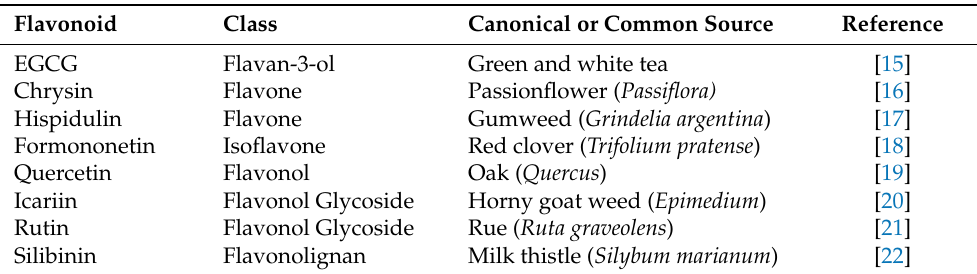
Table 1. Classes and sources of eight flavonoids that synergize with chemotherapeutics to in- hibit GBM.